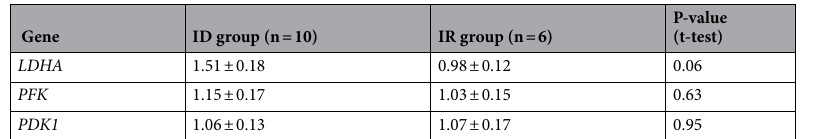
Table 6. Skeletal muscle mRNA expression levels at first visit. Expression data are means ± SE at the mRNA level for lactate dehydrogenase A ( LDHA ), phosphofructokinase ( PFK ), and pyruvate dehydrogenase kinase isoform 1 ( PDK1